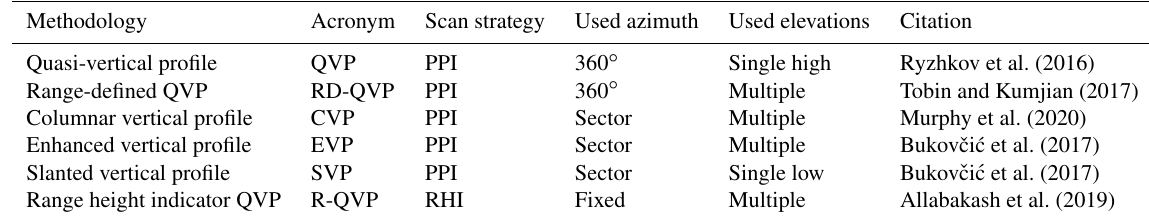
Table 1. Overview of areal averaging techniques to derive quasi-vertical profiles of polarimetric radar variables. Methodology Acronym Scan strategy Used azimuth Used elevations Citation Quasi-vertical profile QVP PPI 360 ◦ Single high Ryzhkov et al. (2016) Range-defined QVP RD-QVP PPI 360 ◦ Multiple Tobin and Kumjian (2017) Columnar vertical profile CVP PPI Sector Multiple Enhanced vertical profile EVP PPI Sector Multiple Bukovˇci´c et al. (2017) Slanted vertical profile SVP PPI Sector Single low Bukovˇci´c et al. (2017) Range height indicator QVP R-QVP Fixed Multiple Allabakash et al.